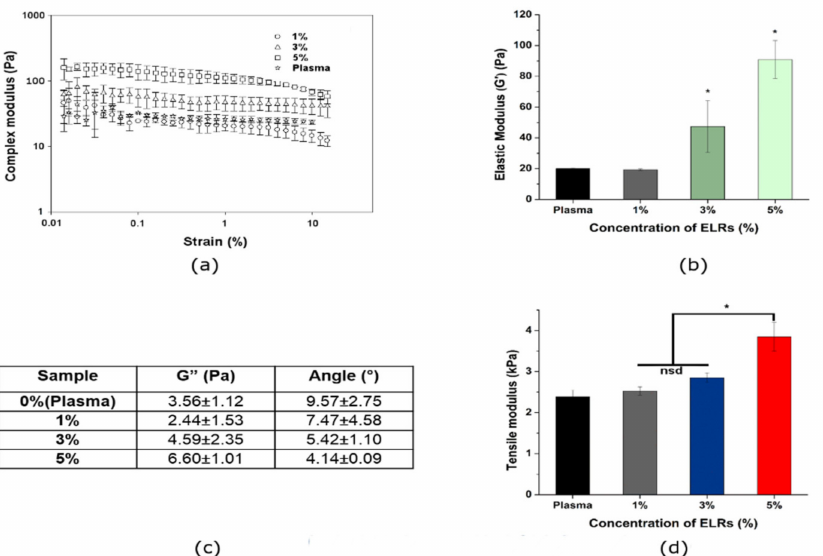
Figure 2. ( a ) Complex modulus of the plasma and hybrid plasma-ELRs hydrogels by strain sweep measurement at 37 ◦ C, ( b ) Elastic modulus (G’) obtained from strain sweep tests of plasma and hybrid plasma-SKSs hydrogels, ( c ) dependence of viscous modulus (G”) and angle on the content of SKSs in the hydrogel composition, ( d ) tensile modulus obtained from strain sweep test of plasma and hybrid plasma-SKSs hydrogels. (* p <